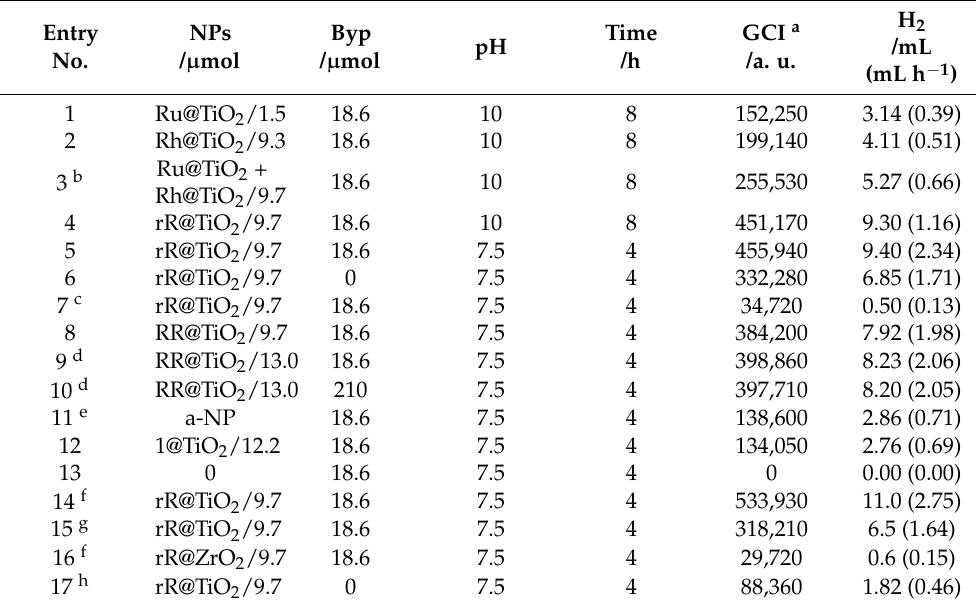
Table 4. Performed dihydrogen generating experiments; see Table 2 for NP